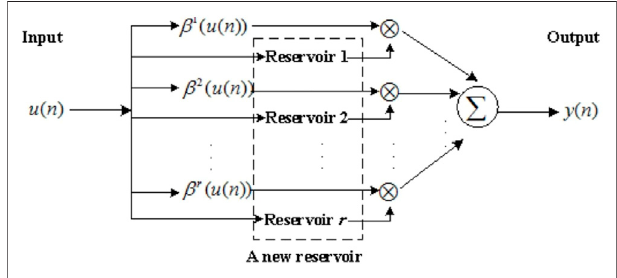
FIGURE 4 | Architecture of